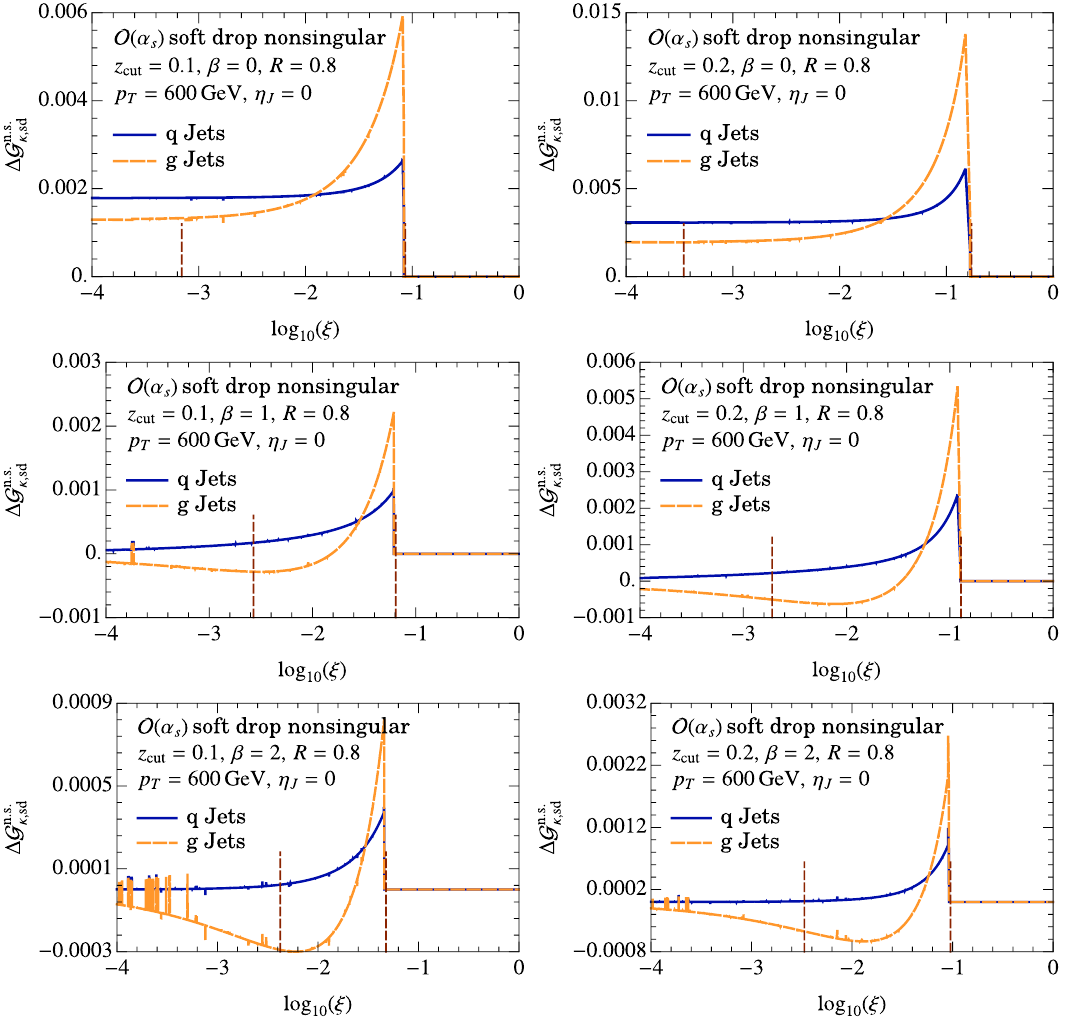
Figure 16 . Soft drop non-singular corrections shown for various combinations of soft drop param- eters and quark and gluon jets. The jaggedness is related to numerical integration. The dashed vertical lines denote the SDOE region given in eq. (4.1), which is also the range chosen for the α s -sensitivity